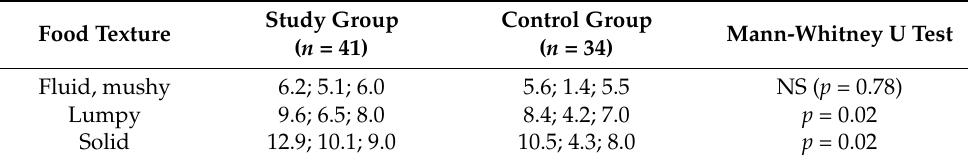
Table 7. Child’s age (in months) at which complementary food with particular texture was introduced to the diet (provided: mean; standard deviation; median) (question I/10).